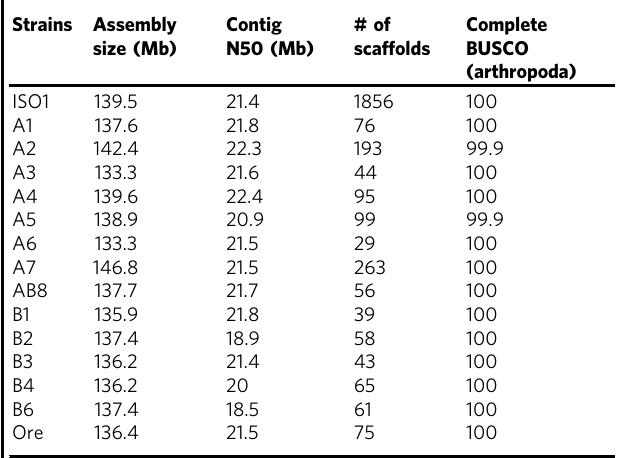
Table 2 Number of euchromatic SVs in the sequenced